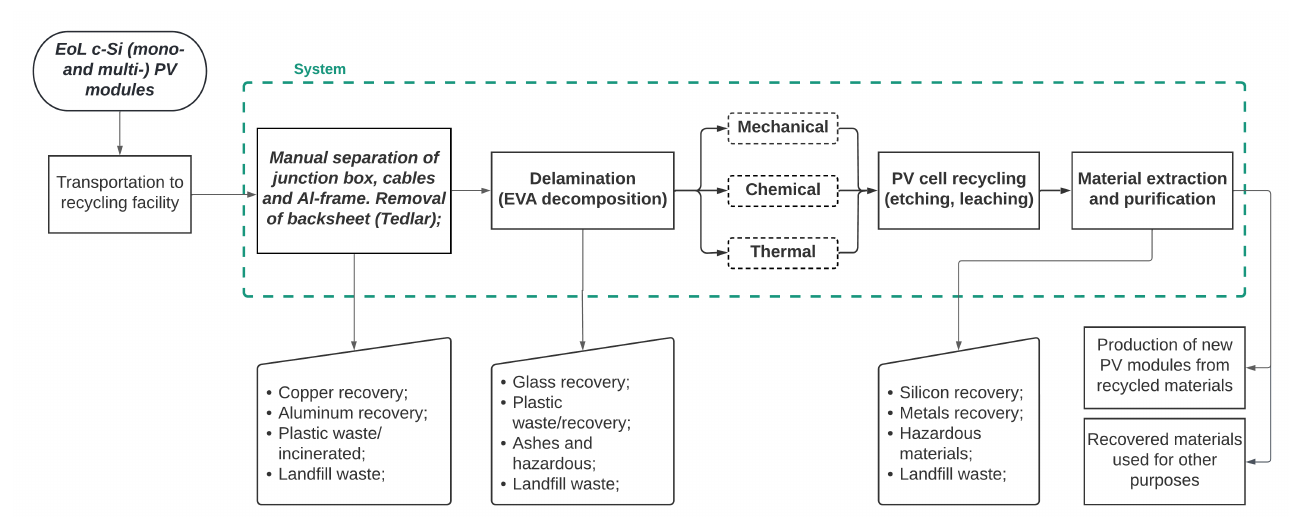
Figure 1. General system definition and boundaries.